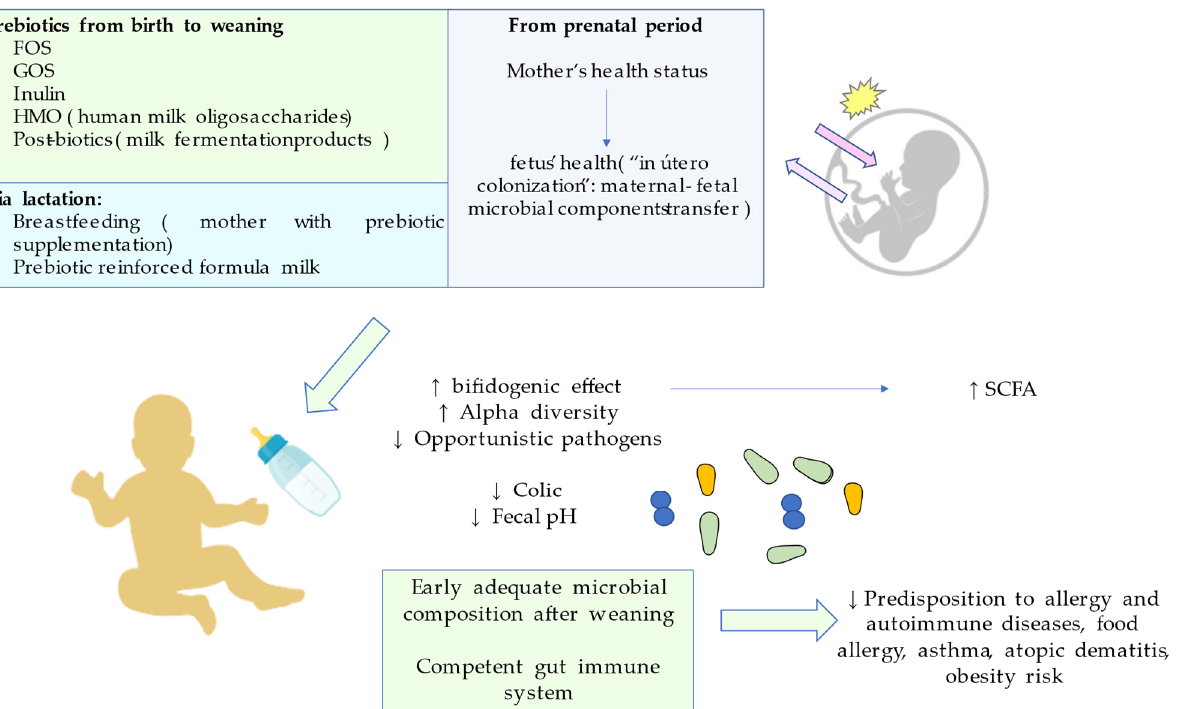
Figure 2. Prebiotics effects on fetus and newborn, from prenatal and lactation until weaning mo- ment.